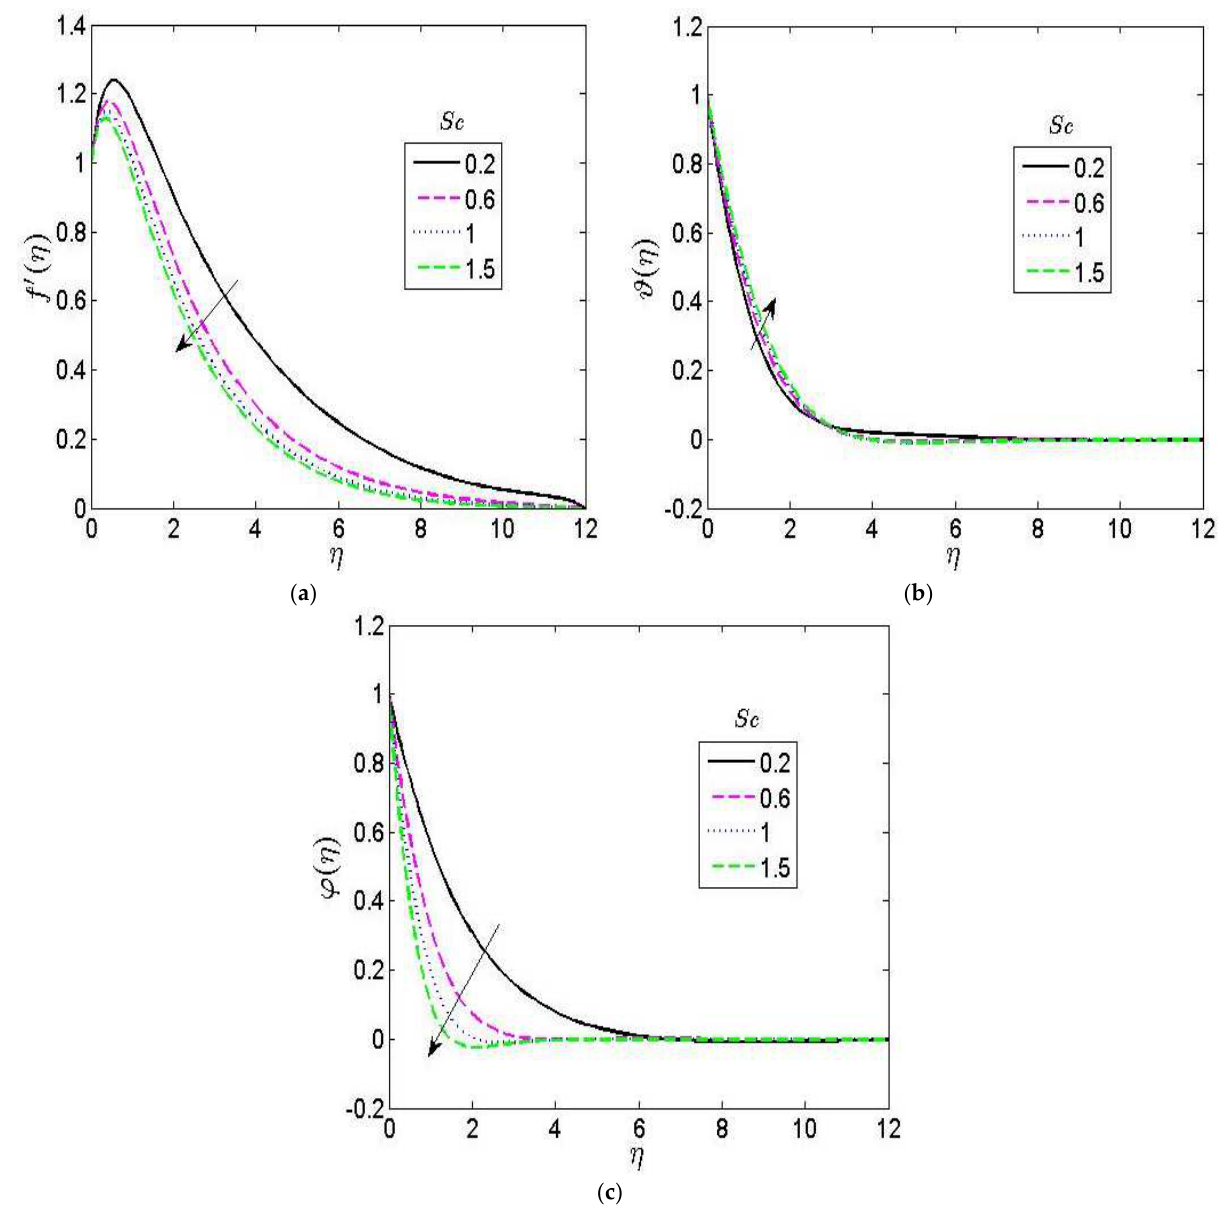
Figure 6. Effect of Schmidt number Sc on ( a ) velocity, ( b ) temperature, and ( c ) concentration profiles. The influence of suction velocity (Sw) is explored in Figure 7. It is noticeable that acceleration in the suction velocity causes an elevation in the velocity, as well as temperature at the plate, but decreases when it is further from the plate as shown in Figure 7a,b. Moreover, from Figure 7c, an elevation in the concentration can be observed when the suction velocity is higher.